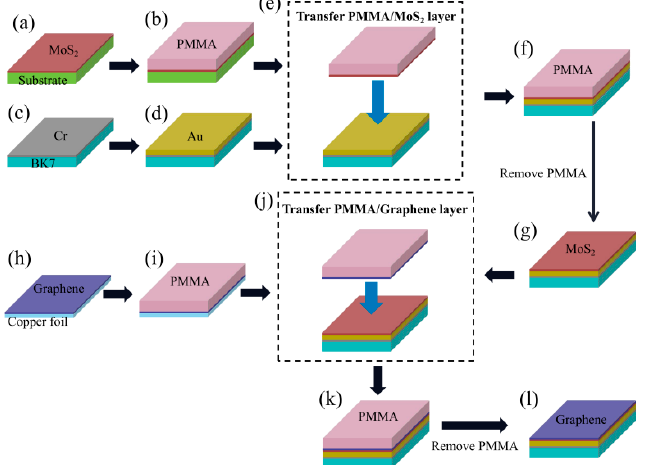
Figure 5. Schematic diagram of fabrication processes of the graphene–MoS 2 hybrid-structure sensor. ( a ) MoS 2 deposition using CVD, ( b ) PMMA spin-coating, ( c ) Cr deposition using magnetron sputtering, ( d ) Au deposition using magnetron sputtering, ( e ) separation of PMMA/MoS 2 from SiO 2 /Si substrate using KOH, ( f ) PMMA/MoS 2 transferring to Au-based substrate, ( g ) PMMA removal using acetone, ( h ) monolayer-graphene deposition using CVD, ( i ) PMMA spin-coating, ( j ) etching the Cu foil using FeCl 3 , ( k ) PMMA/graphene transferring to MoS 2 -based substrate, ( l ) PMMA removal us- ing acetone.